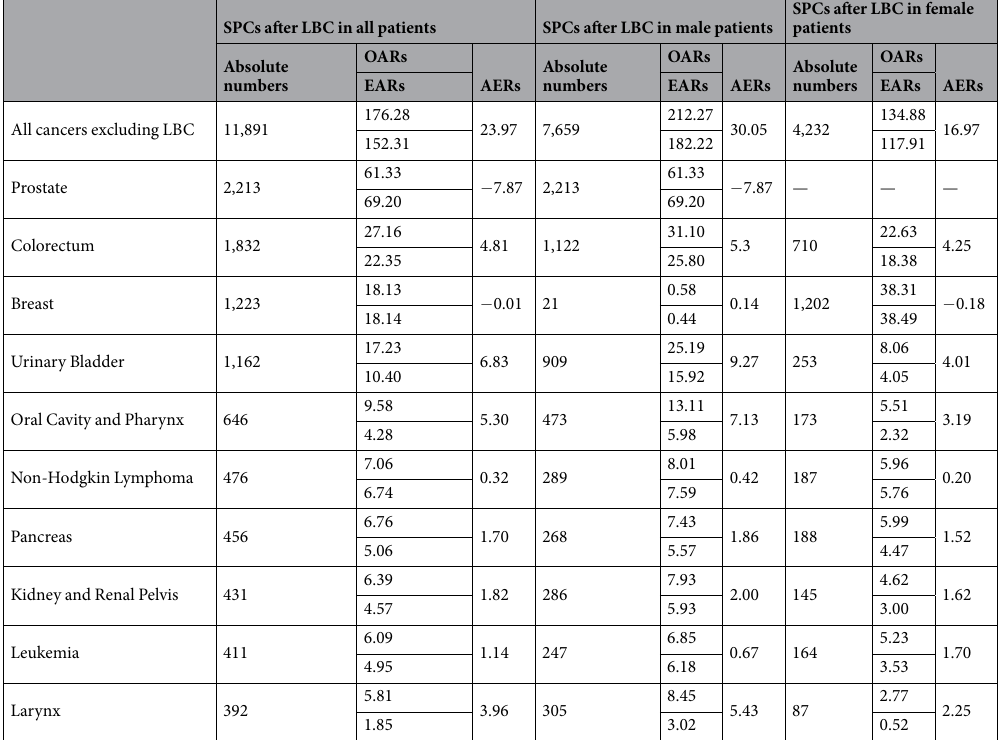
Table 2. OARs, EARs, and AERs of SPCs after LBCs. Abbreviations: SPC, subsequent primary cancer; LBC, lung and bronchus cancer; OAR, observed annual risk; EAR, expected annual risk; AER, Annual excess